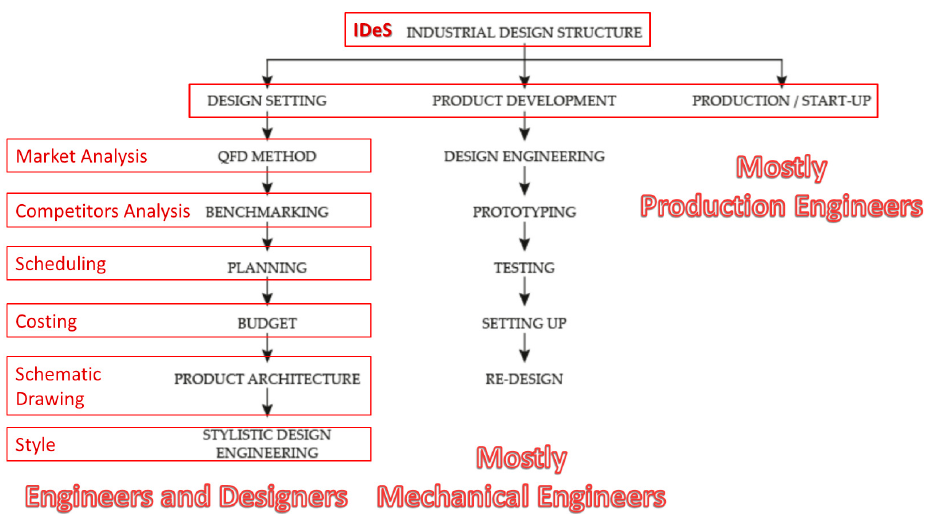
Figure 28. IDeS vs. human resources.